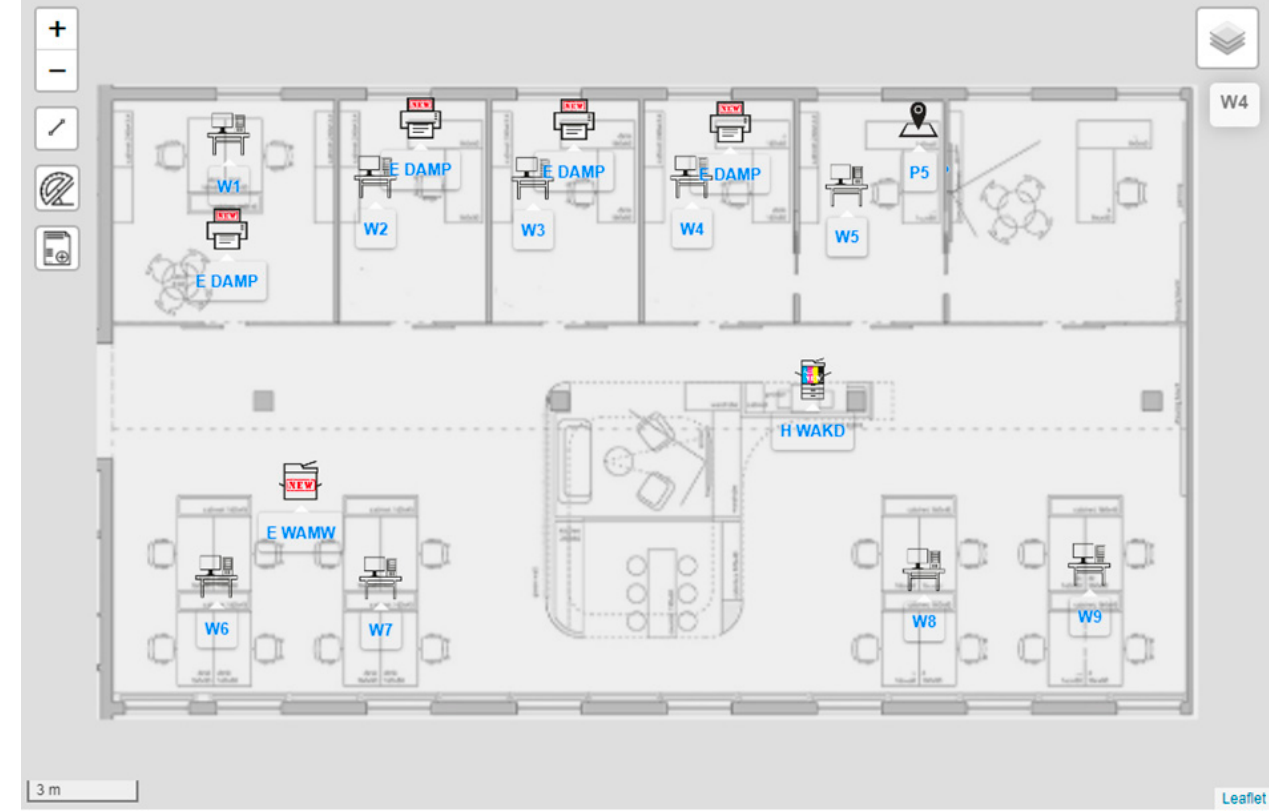
Figure 8. REF + EC scenario results—assignment of printing devices to places and workstations. Table 7. REF + EC scenario results—printed/copied page volume of each printing device.